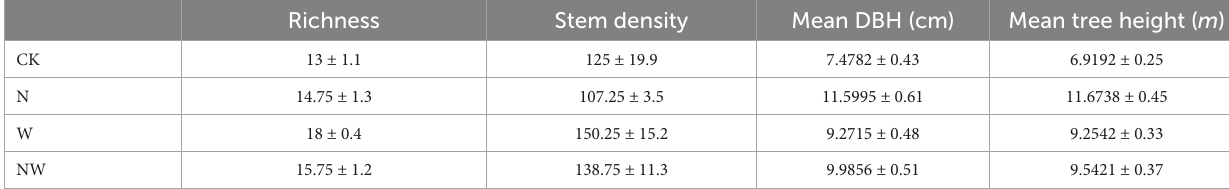
TABLE 1 Number of plant species and individuals in the different treatment sample